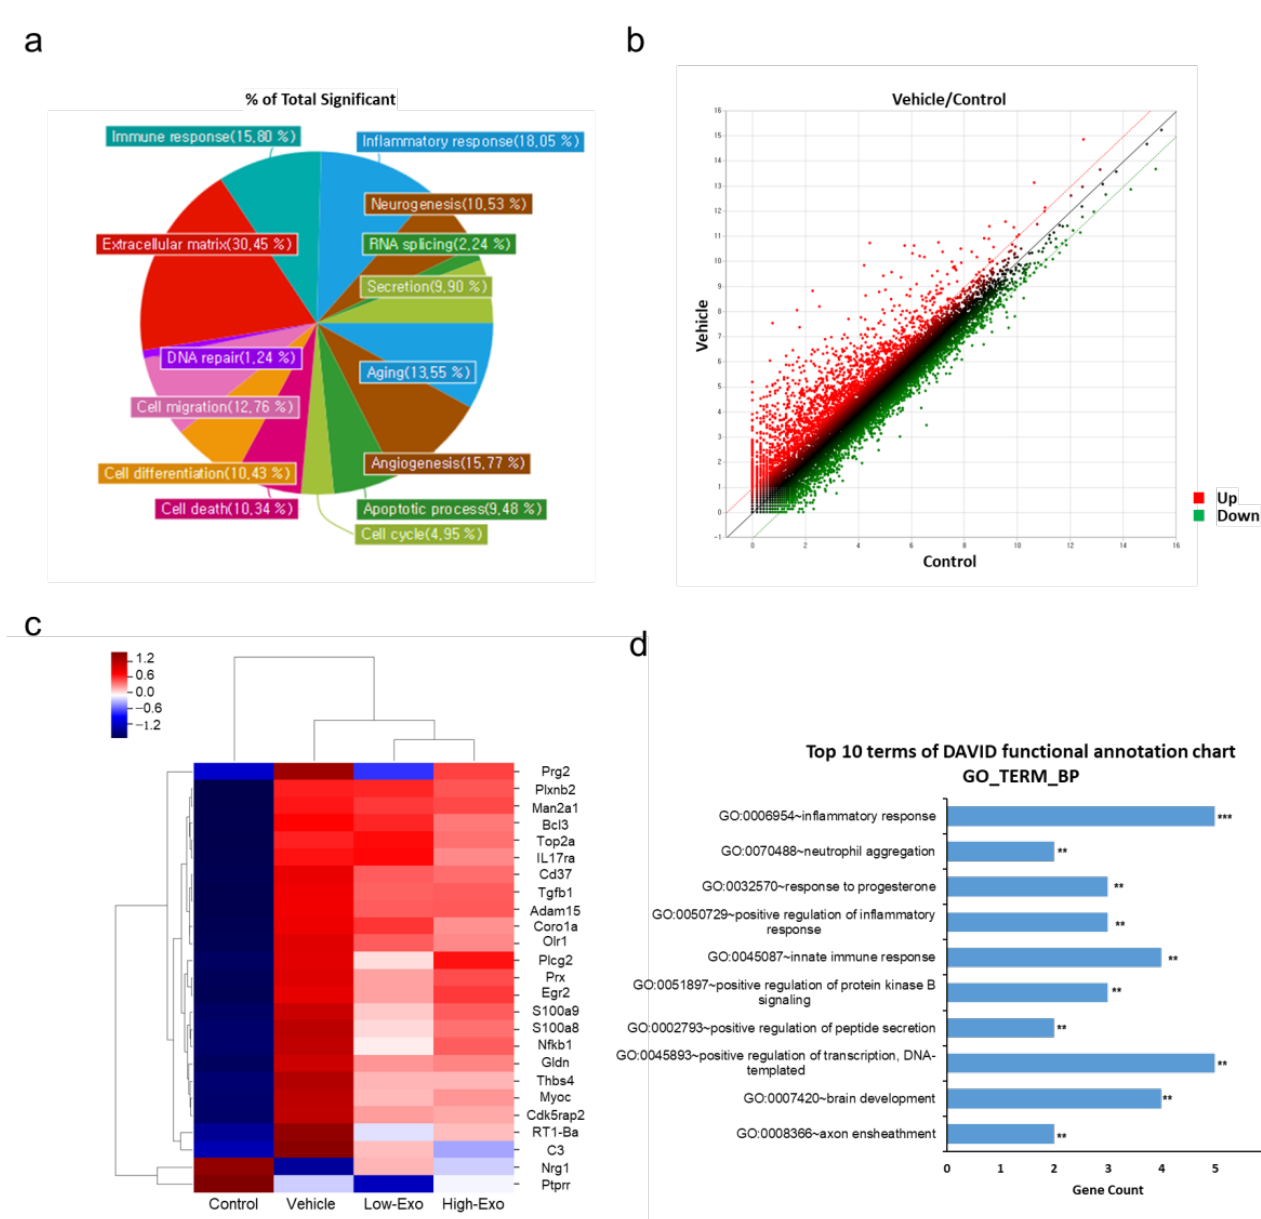
Figure 7. Comparison of gene expression level by mRNA sequencing: ( a ) gene category chart of the control and vehicle groups. The ratio of significant genes according to each gene category; ( b ) scatter plot of normalized data (log2N) for each gene. X-axis represents control (log2N), and y-axis represents vehicle value (log2N), upregulated genes (red) and downregulated genes (green); ( c ) clustering heatmap for genes with significantly altered expression; ( d ) top 10 Gene Ontology (GO) biological process (BP) terms of genes with significantly altered expression in the exosome-treated groups, compared with that in the vehicle group (** p < 0.01, *** p < 0.001).